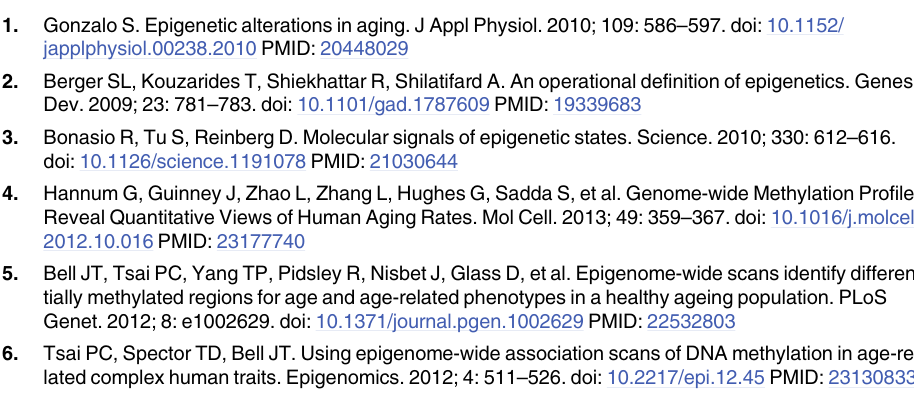
The corresponding coefficients were used for representative plotting within each dataset. The black lines represent the identity of coefficients before and after RefFreeEWAS adjustment. S3 Fig. Reproducibility of HIV and Age Coefficients between Data Sets before and after RefFreeEWAS-adjustment. Reference Free EWAS models were generated using HIV status and age as covariates. Pearson ’ s correlation was computed between data sets 1 and 2 for before and after adjustment. Representative plots were generated by randomly sampling one percent of applicable CpGs and plotting their corresponding covariate coefficients for comparison be- tween data sets. The black lines represent the identity of the coefficients between datasets. S1 Table. Multivariate regression model determining contribution of CD57 + CD28 - CD8 + T cells to differences in methylation with HIV